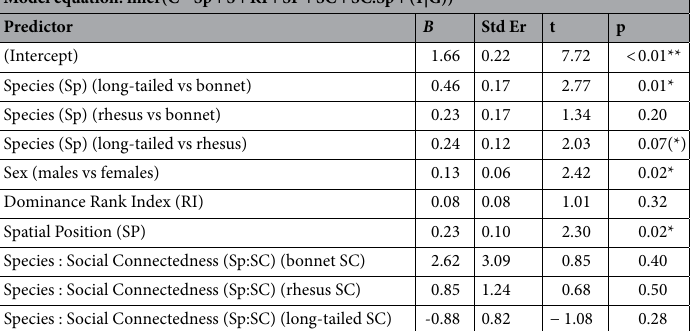
Table 3. Best-fit GLMM examining the impact of macaque attributes on the complexity (C) of human– macaque interactions. Group (G) was a random effect. **p < 0.01; *p < 0.05; (*)0.05 < p <